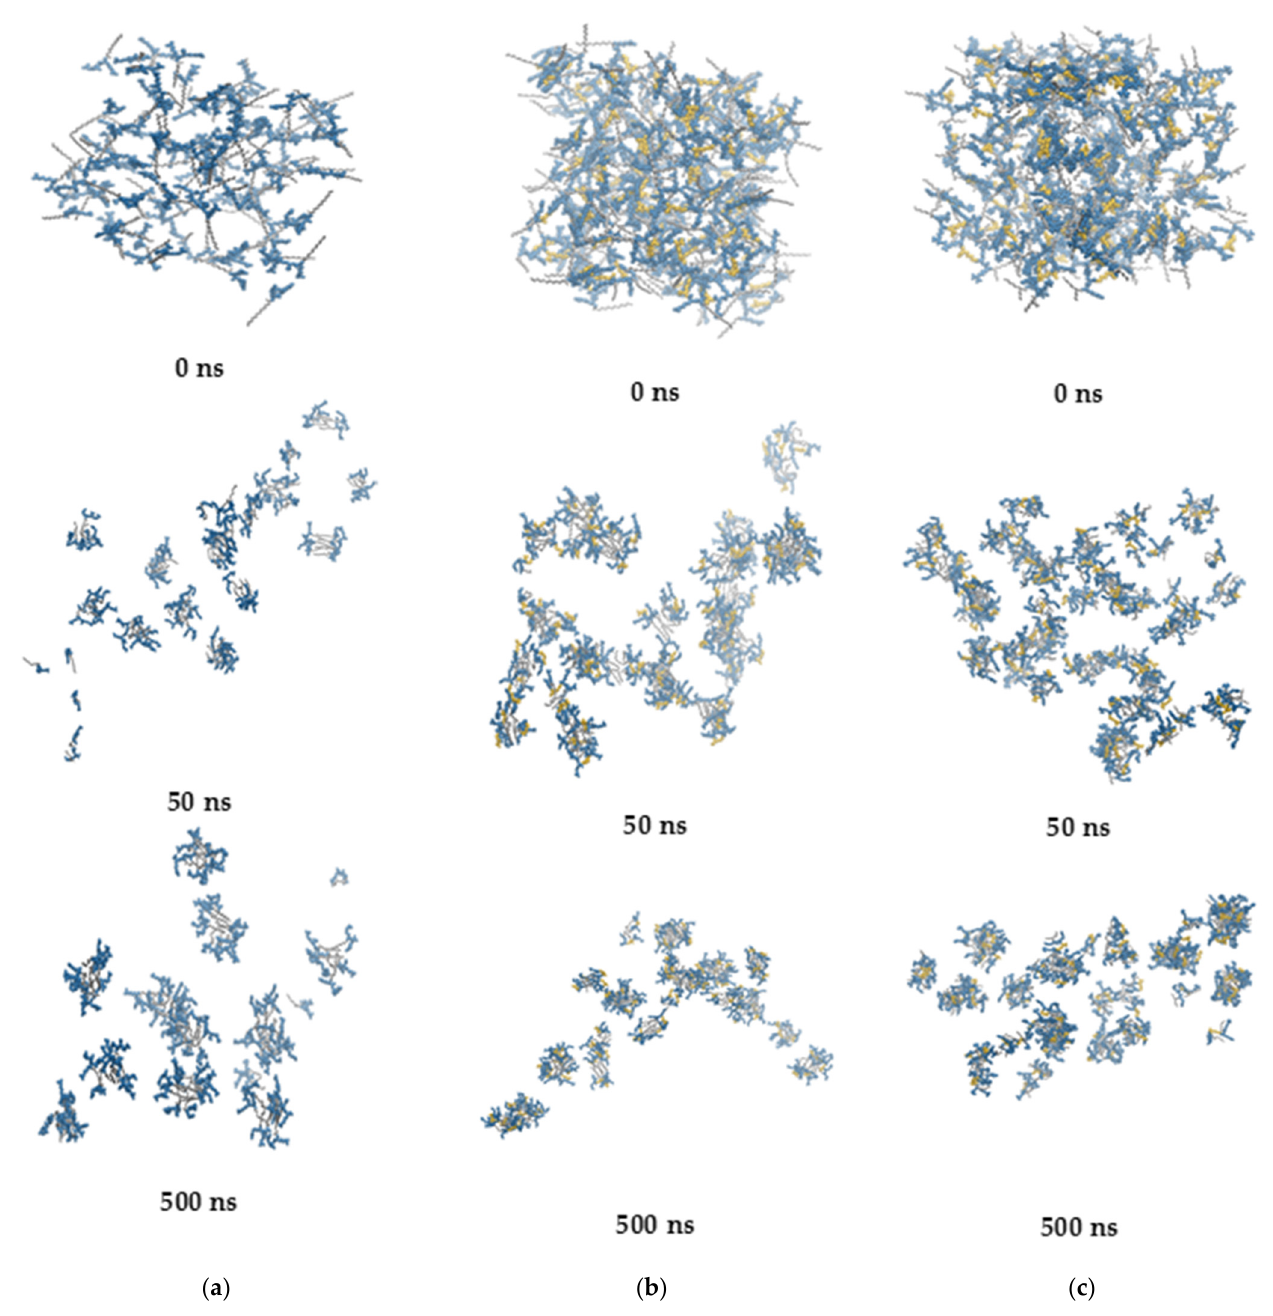
Figure 13. Snapshots from the self-assembly simulations. ( a ) A3 , ( b ) B3 , and ( c ) B7 . Fatty acid tails are in gray, arginines are in blue, whereas the lysine linker is in yellow.